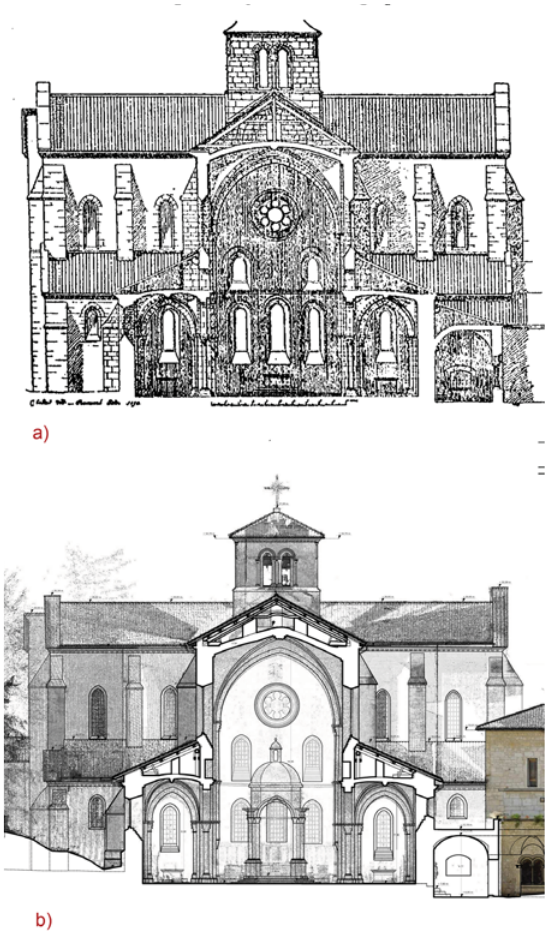
Figure 7. a) Cross section by Enlart (1894); b) Cross section by Survey